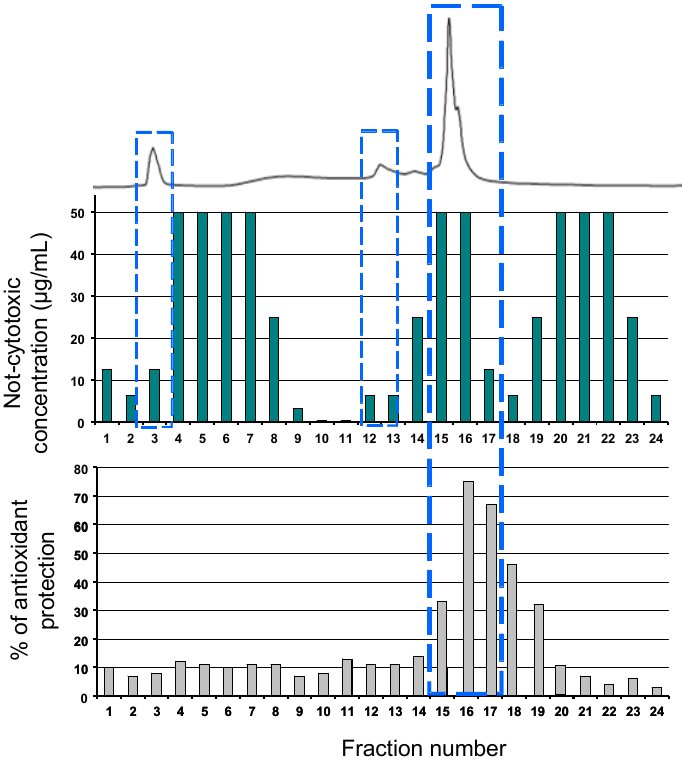
Figure 3. Correlation between chromatographic profile of Kalanchoe pinnata leaf methanolic extract and cytotoxicity and antioxidant DCHH-DA